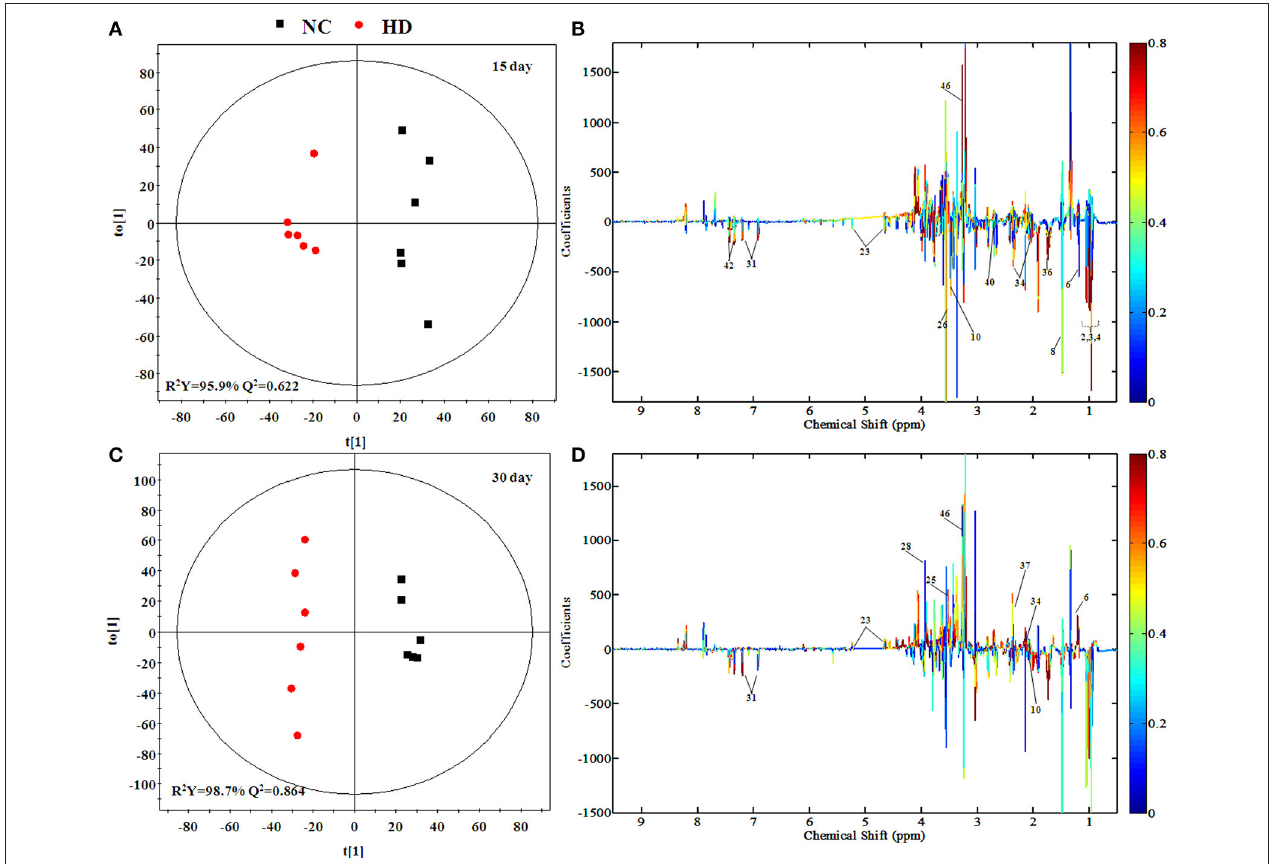
FIGURE 6 | OPLS-DA scores plots (A,C) and coefficient loading plots (B,D) derived from 1 H NMR spectra of kidney extract from HD and NC group at day 15 and day 30. The color code corresponds to the correlation coefficients of the metabolic variables. The loading plots identifying discriminatory metabolites between HD and NC group are based on the first principal component [ t (1) ]. Signals with a positive direction relate to the abundance of metabolites in the groups in the positive direction of [ t (1)], and vice versa.